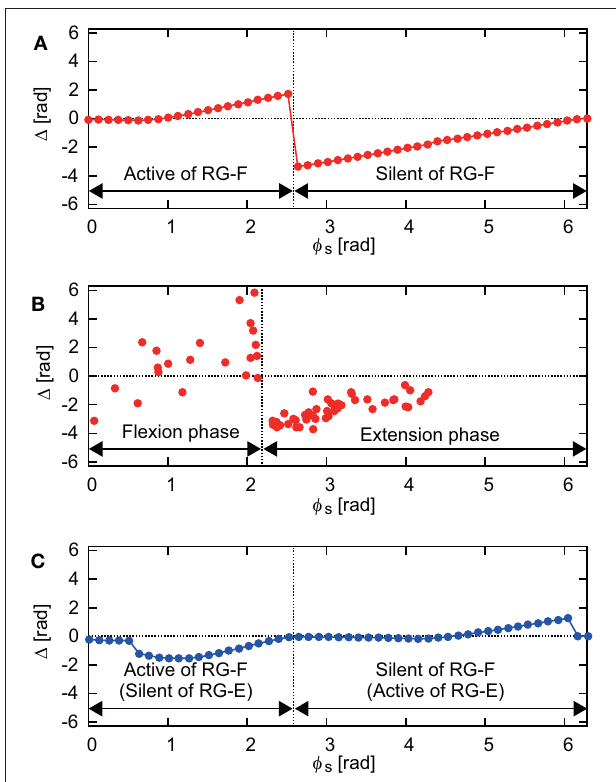
FIGURE 3 | (A) Phase-dependent response of the RG-F neuron by stimulating sensory fibers of the flexor side. (B) Response against flexor muscle stimulation during fictive locomotion in cats (adapted from Schomburg et al., 1998). The flexion (extension) phase corresponds to the active (silent) phase of the RG-F neuron of the CPG model. (C) Phase-dependent response of the RG-F neuron by stimulating sensory inputs on the extensor side.